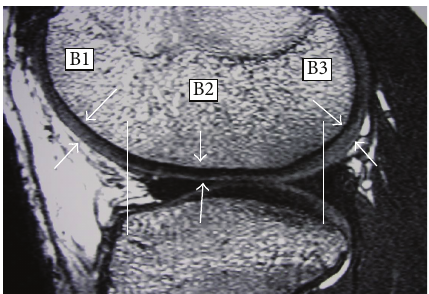
Figure 2: Mapping of MRI showing regions that are B1, B2, and B3. White arrows show cartilage thickness in these three regions.